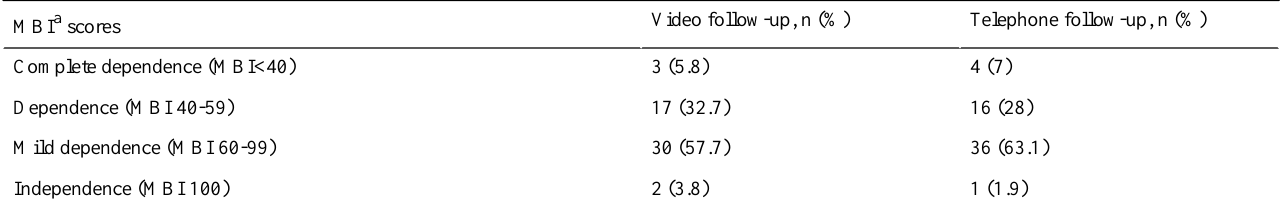
Table 3. Distribution of discharge Modified Barthel Index scores in the videoconference follow-up and telephone follow-up